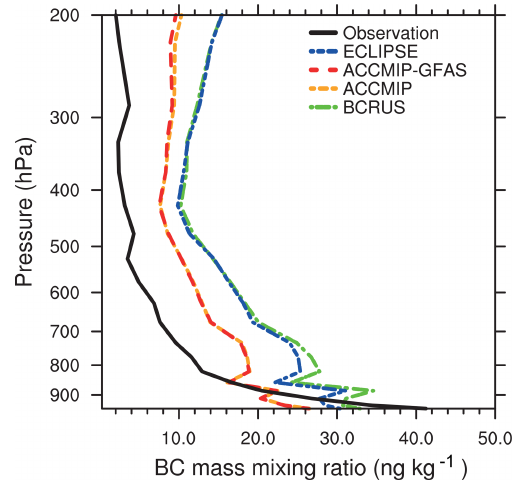
Figure 10. Vertical profiles of BC mass mixing ratios from air- borne in situ measurements during the flight campaign HIPPO-1 campaign in January 2009. The modeled BC mass mixing ratios were averaged over the vertical levels. The observations are shown in black, and the different model runs are color coded (see Sect. 4 for